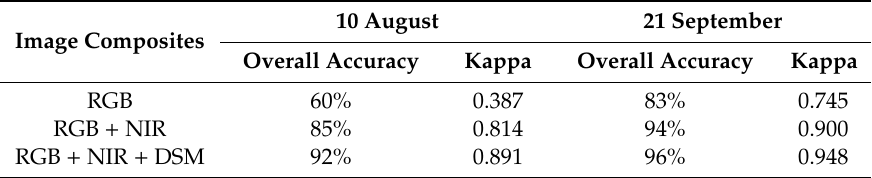
Table 6. Accuracy assessment results for three image composites at the Yizhu sampling site. Image Composites